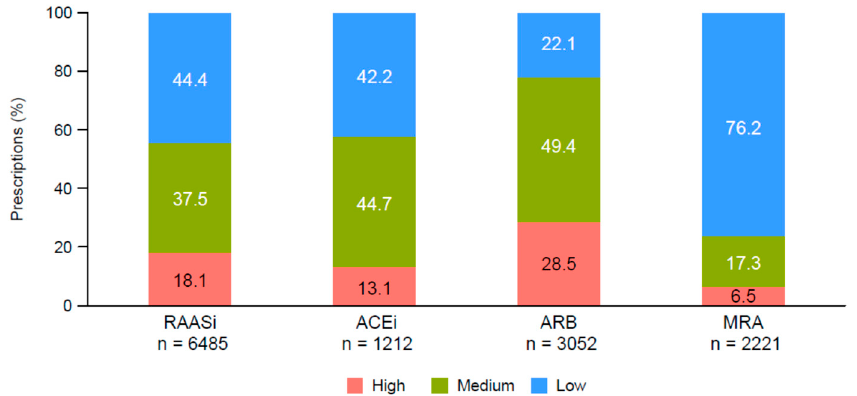
Figure 3. RAASi treatment according to dosage category (high, medium, or low) at the index date. Percentages were calculated using the total number of prescriptions. Abbreviations: ACEi, angiotensin-converting enzyme inhibitor; ARB, angiotensin receptor blocker; MRA, mineralocorticoid receptor antagonist; RAASi, renin–angiotensin–aldosterone system inhibitor.